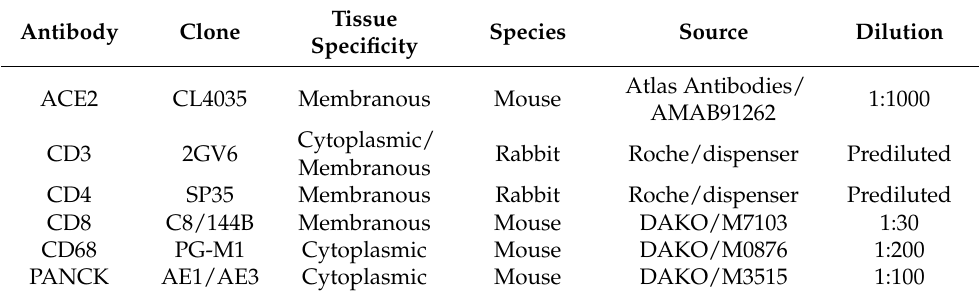
Table 1. Antibodies used for immunofluorescence